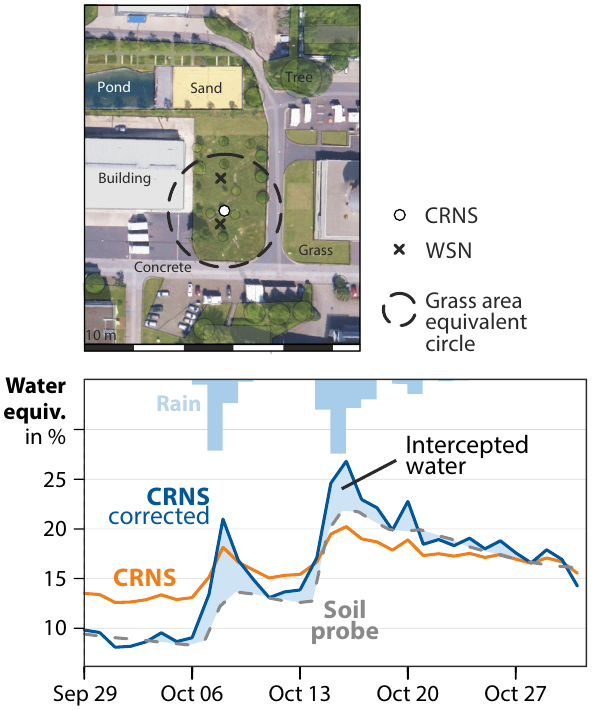
Figure 9. Top: illustration of the circular area (dashed) around the CRNS probe 7 that confines an area equivalent to the non-sealed grassland meadow. Bottom: demonstrating the area correction ap- proach (Eq. 11). The constant contribution of neutrons from the sealed area leads to a damped signal of soil moisture dynamics mea- sured by the CRNS (orange line). The corrected signal (blue line) shows more pronounced dynamics based only on the areal contri- bution of the meadow. The remaining deviation (shaded blue) from the WSN soil moisture measurements (grey dashed) probably rep- resents intercepted water over the sealed ground during and after rain